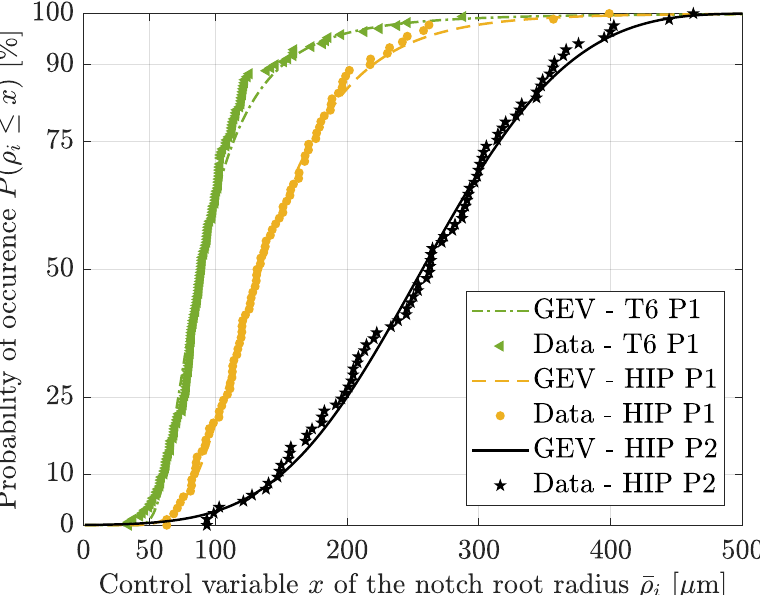
≤ x ) of the ρ General Extreme Value (GEV) distributions. i i